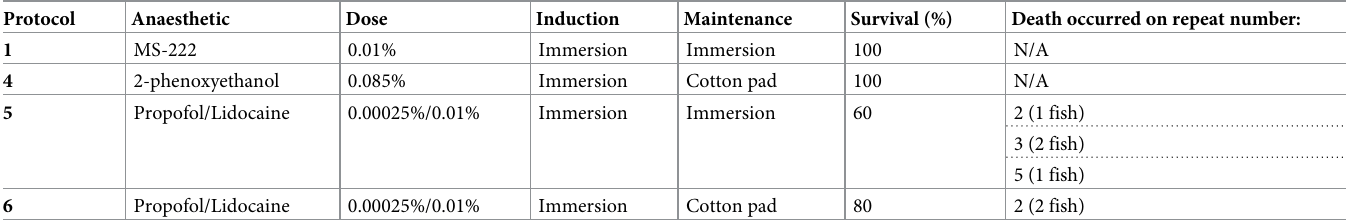
Table 4. Protocol numbers and the corresponding procedures.